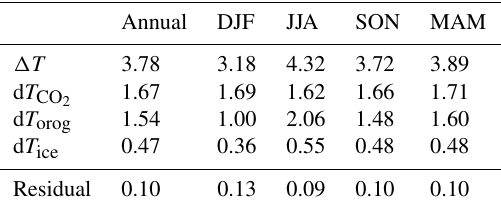
Table 3. Annual and seasonal global mean SAT anomalies between the mid-Pliocene and the PI and the contributions to these anomalies from changes to the boundary conditions. The residual is the quan- all cases. All values are in units of ◦